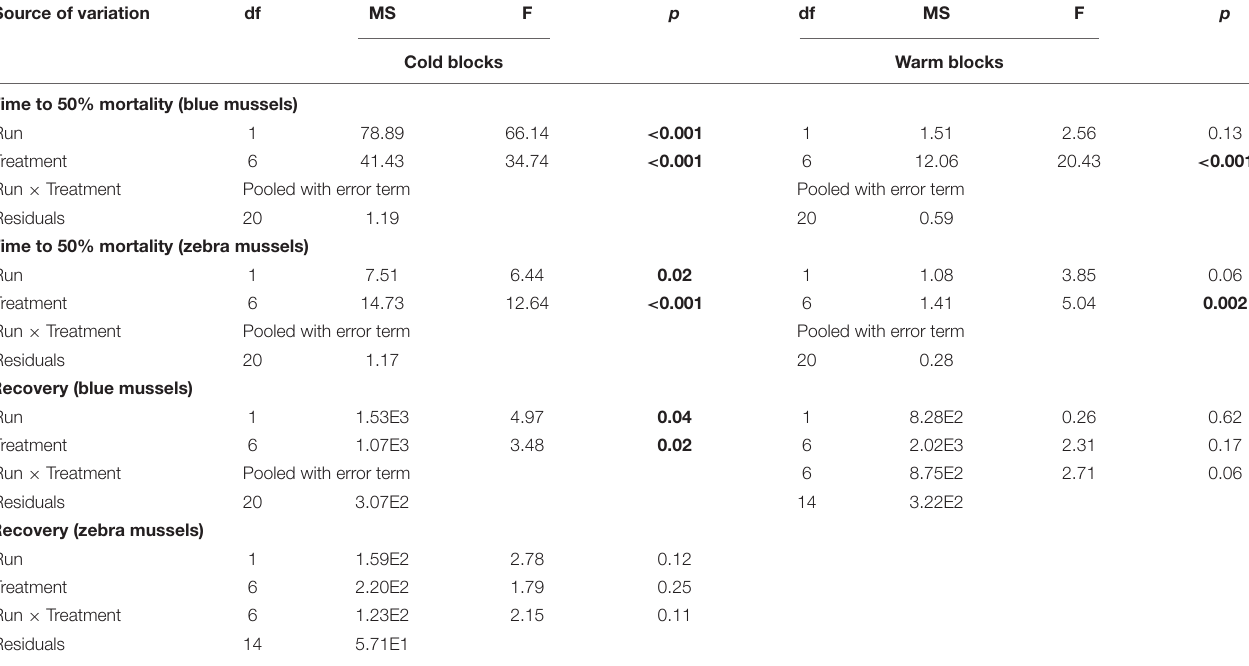
Significant effects (p < 0.05) are indicated in bold. TABLE 3 | Results of two-way factorial ANOVAs evaluating the effect of treatments on the survival of blue mussels ( Mytilus edulis ) and zebra mussels ( Dreissena polymorpha ). Source of